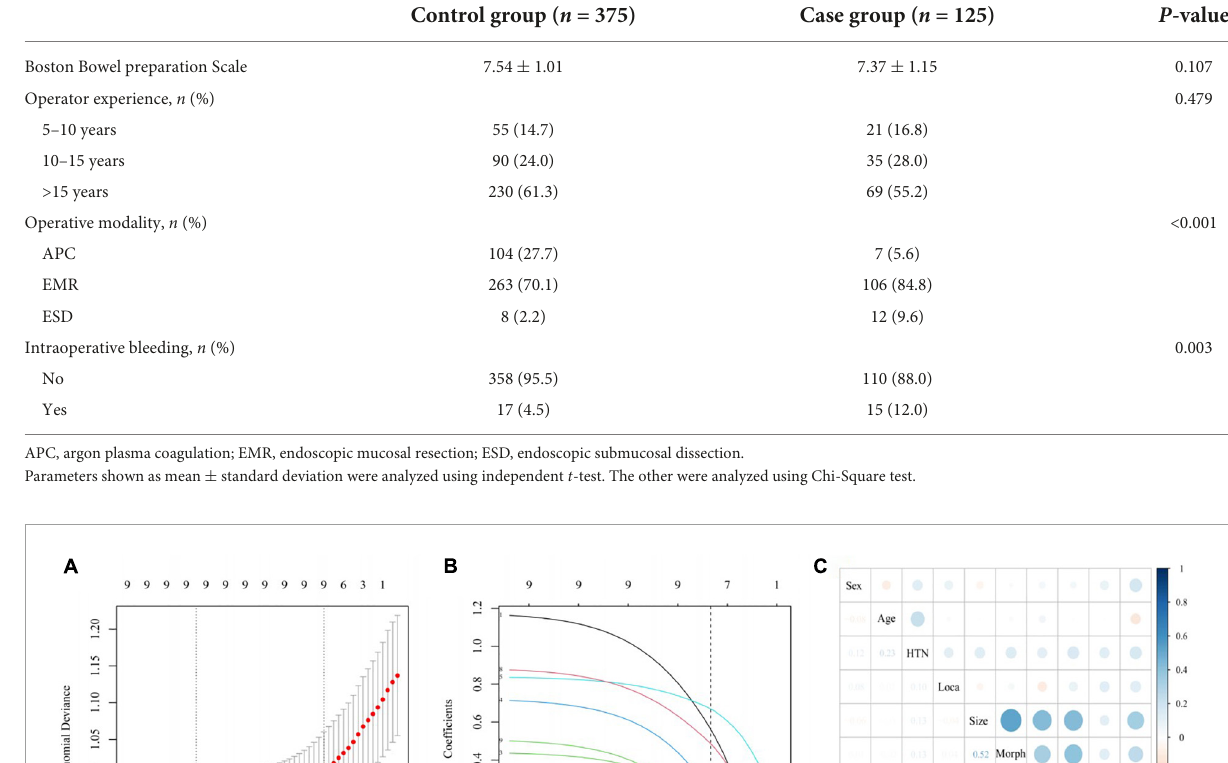
TABLE 3 Comparison of operation-related factors of delayed post-polypectomy bleeding in two groups.